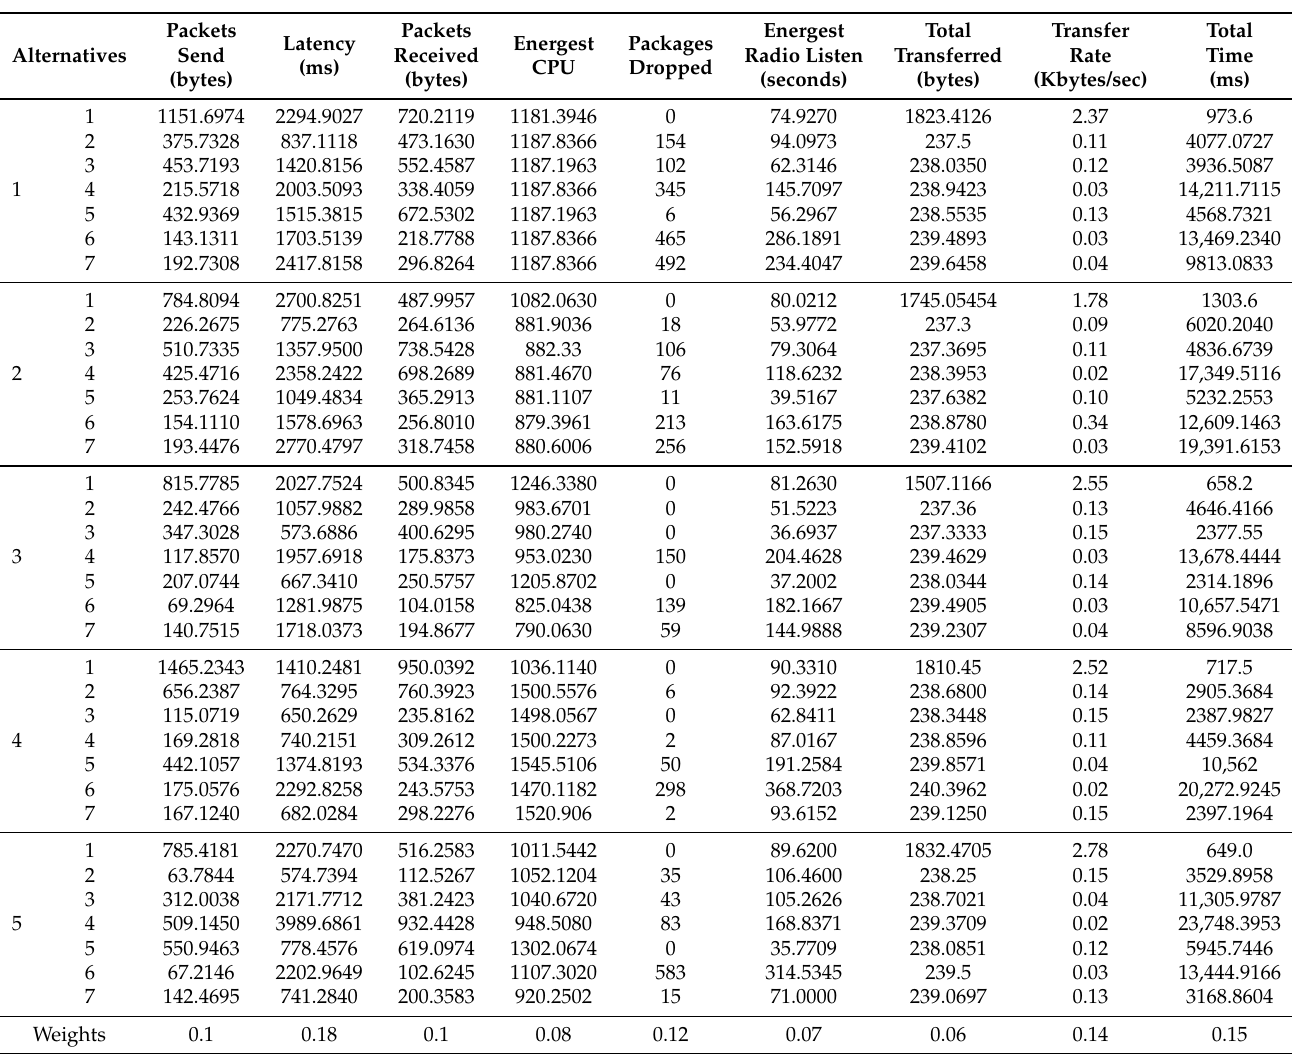
Table 3. Decision